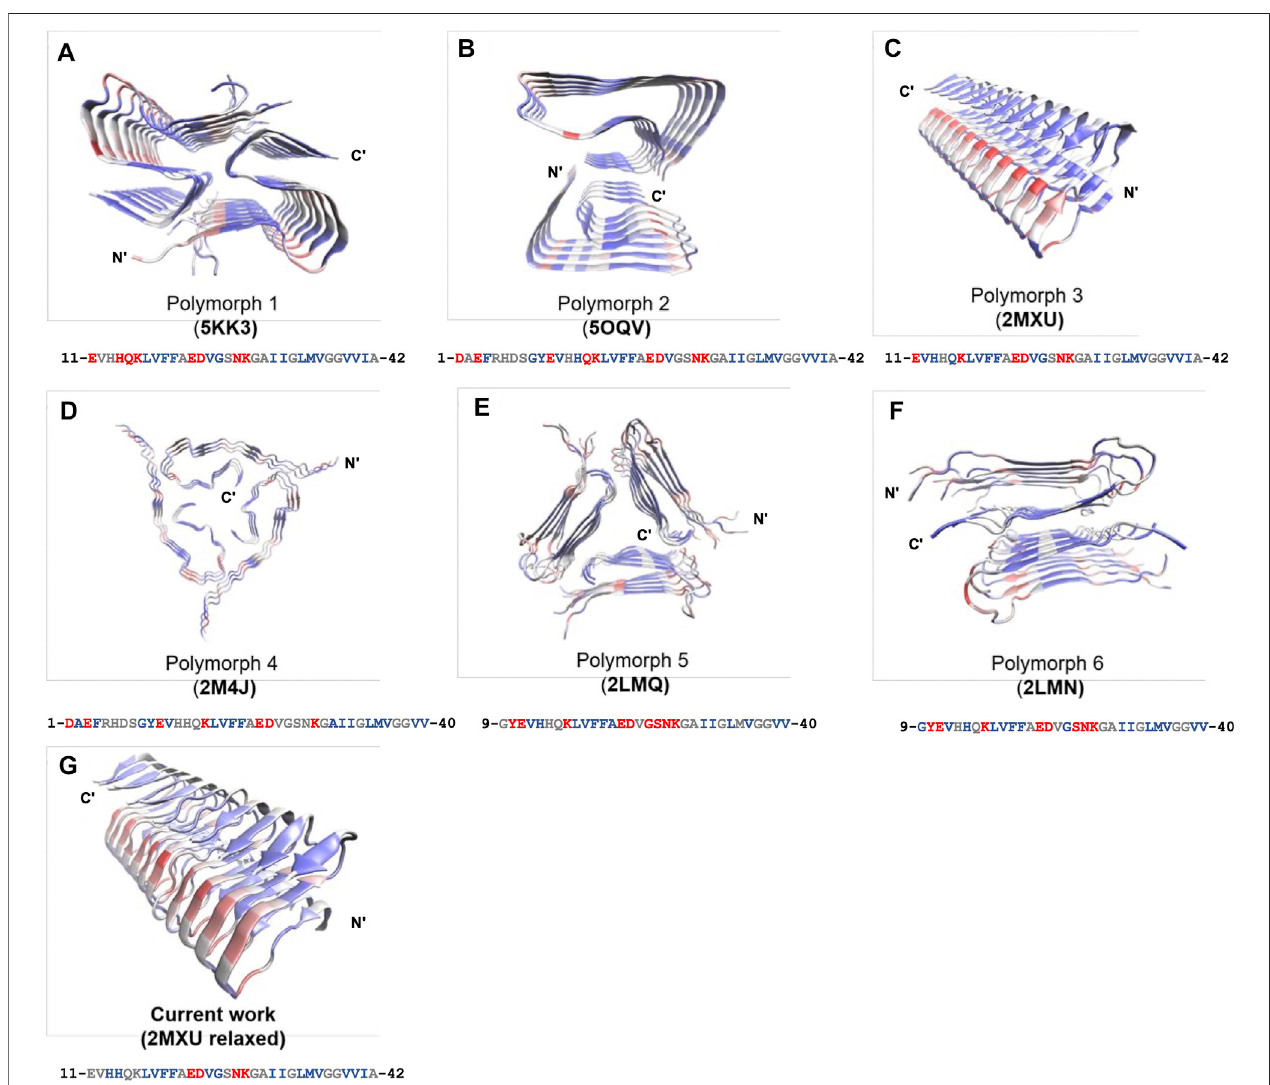
FIGURE5| Frustrationpro fi lesforavarietyofpolymorphic fi brillarstructuresofAbetapeptidesavailabletodate. (A) 5KK3. (B) 5OQV. (C) 2MXU. (D) 2M4J. (E) 2LMQ. (F) 2LMN. (G) MD-relaxed structure using 2MXU. The magnitude of frustration is quanti fi ed using different colors with red (highly frustrated), grey (neutral), and purple (minimally frustrated). The frustration pro fi le is obtained using the frustratometer server (http://frustratometer.qb.fcen.uba.ar/). Single-residue frustration mode is adopted throughout the analysis. Note that for each panel, a 1D sequence representation is shown below (residues are colored using the same frustration color code).